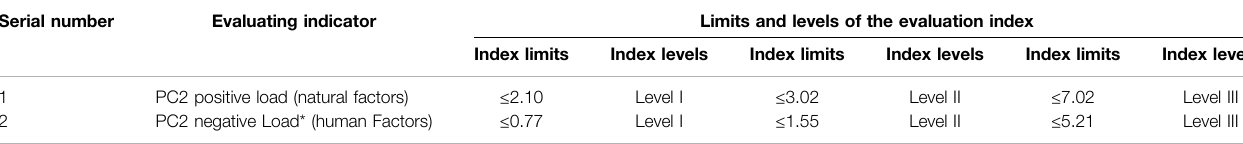
TABLE 2 | Principal component score evaluation level under the guidance of various